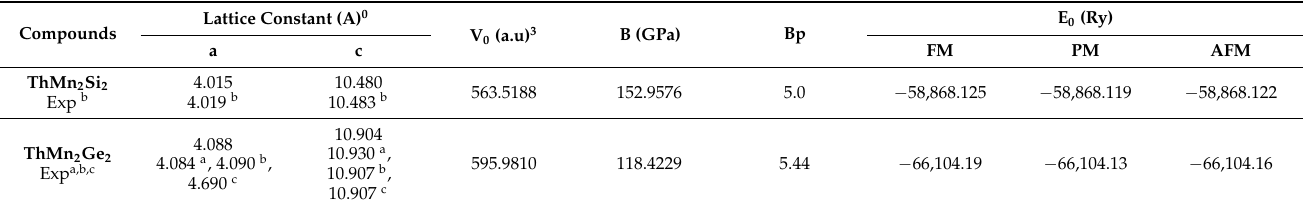
Table 1. Noted unit cell parameters of ThMn 2 Si 2 and ThMn 2 Ge 2 compounds, together with available experimental studies.